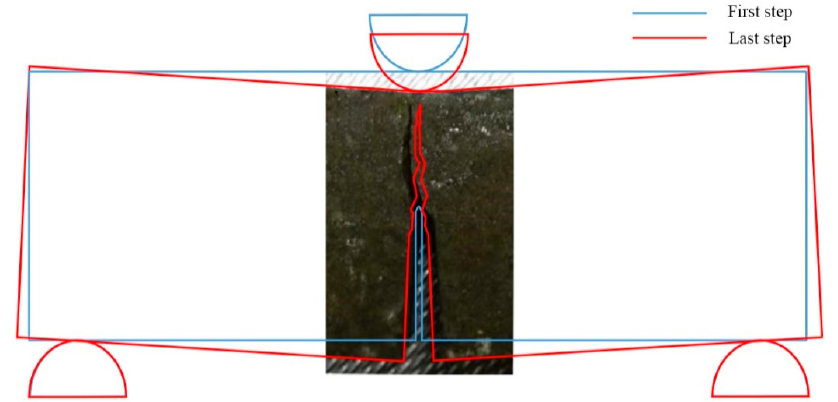
Figure 8. The damage pattern of the three-point bending test of the specimen B3 in the numerical simulation and test.